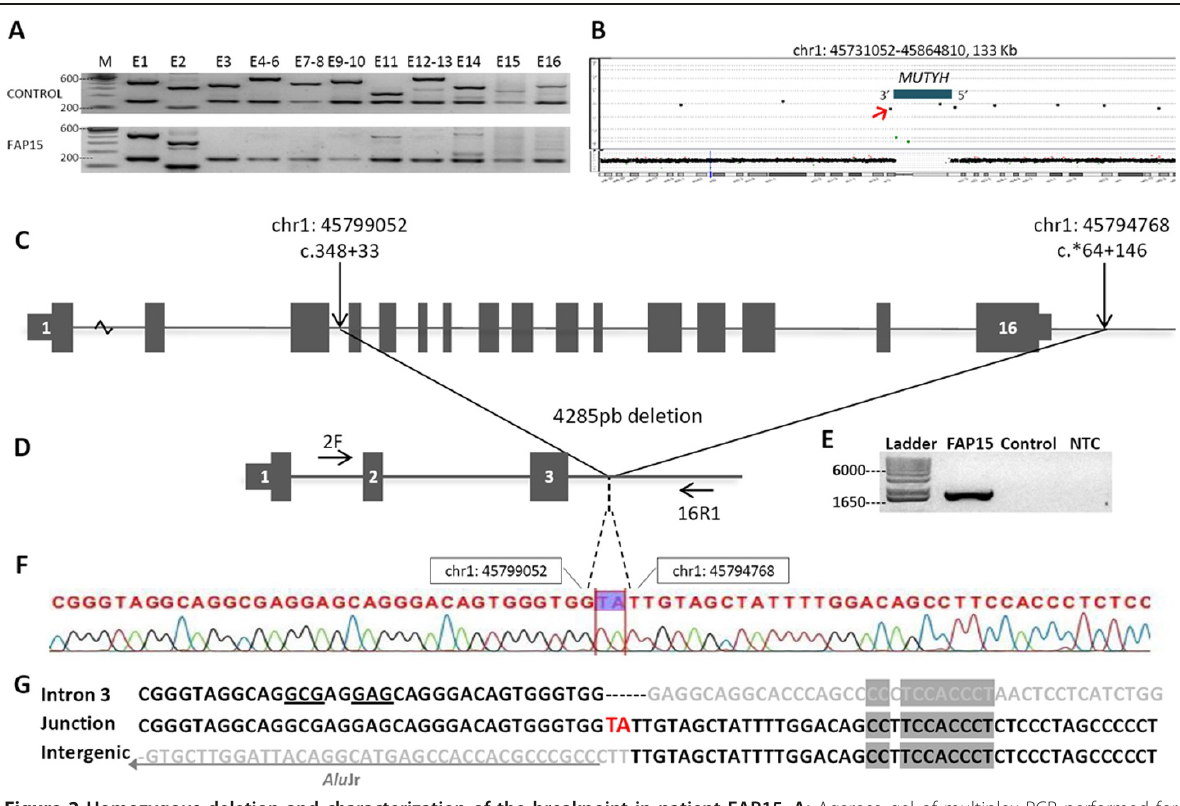
Figure 2 Homozygous deletion and characterization of the breakpoint in patient FAP15 . A: Agarose gel of multiplex PCR performed for MUTYH exons 1 to 16 (E1-E16) and control genes GAPDH or HPRT1 . The patient (FAP15) exhibited absence of amplification for MUTYH exons 3 to 16, whereas a healthy individual (Control) presented all expected fragments. B: The blue line on the profile of chromosome 1 (bottom panel) indicates the mapping at 1p34.1 of the two intragenic probes with log 2 ratio values compatible with a homozygous deletion (green circles, upper panel); probes flanking this deletion (at 5 ’ of MUTYH , and downstream of its 3 ’ end) exhibited normal values. The red arrow indicates the position of probe A_14_P118536 where novel reverse primers were designed. C: Schematic drawing of the normal gene with genomic and cDNA (NM_001128425.1) positions of the breakpoints. D: Schematic drawing of the deleted gene and primer locations (2F primer: chr1: 45800257-45800276; 16R1 primer: chr1: 45794388-45794407). E: Agarose gel showing the amplification of the deletion junction in the patient and amplicon absence in the control DNA pool. F: Partial chromatogram of the junction sequencing showing in highlight the two inserted nucleotides (TA). G: Nucleotide sequence around the deletion breakpoints and the deletion junction. Red larger nucleotides are the non- template insertion (filler DNA). Light gray nucleotides indicate the deleted sequence. Shaded nucleotides represent shared sequences between the breakpoints. Rearrangement-promoting elements GAG/GCS* are shown underlined. The gray arrow beneath the intergenic deleted sequence shows the location of the Alu Jr element. *S denotes the ambiguity code symbol for G/C. Coordinates at chromosome 1 are given according UCSC Feb. 2009 (GRCh37/hg19)